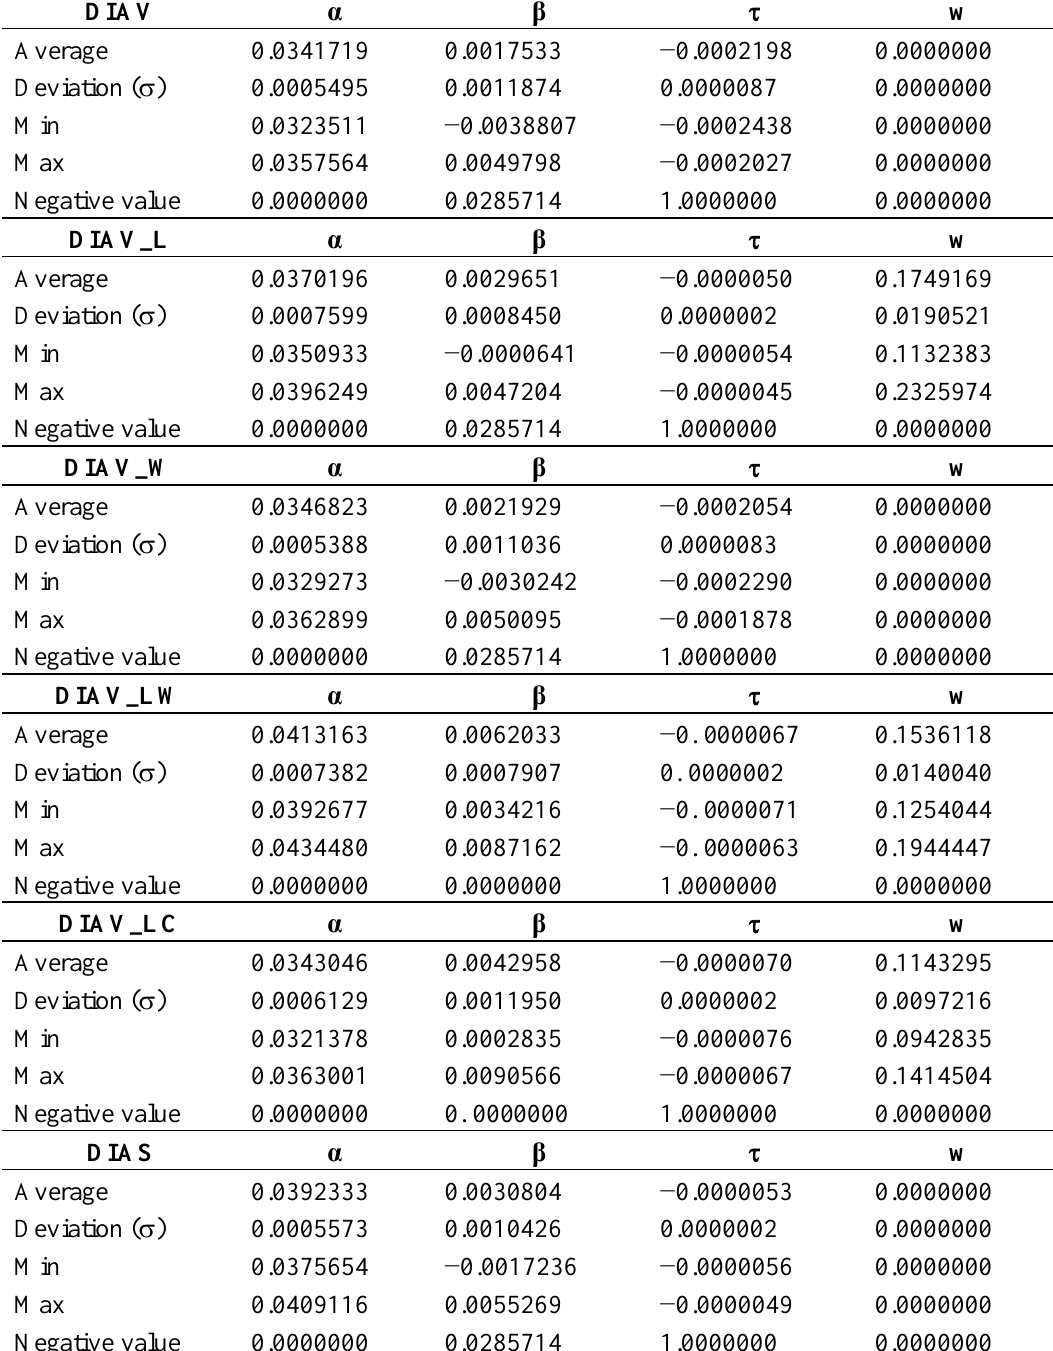
Table 2. Summary of parameters determined by the cross-validation